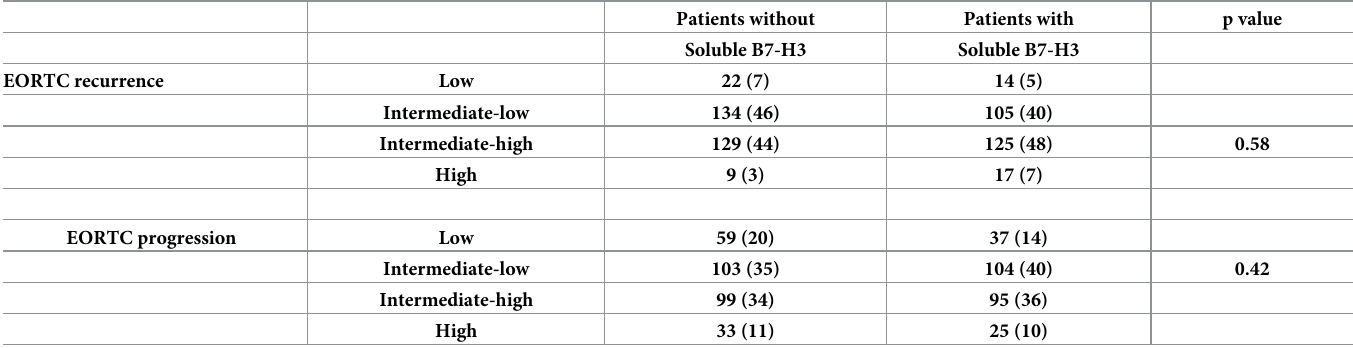
Table 5. Characteristics of patients with and without soluble B7-H3.